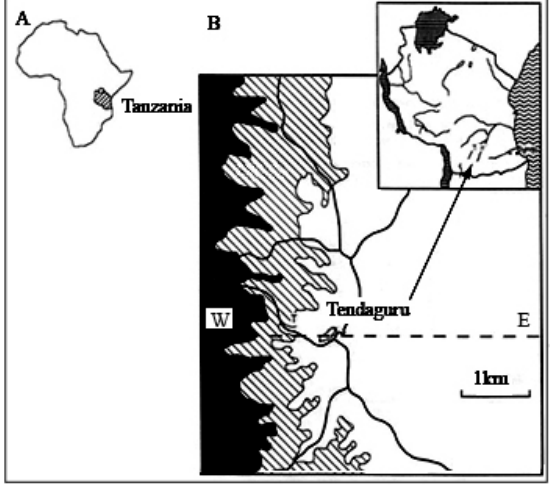
Fig. 1 – Locality map. A. Africa, showing the location of Tanzania. B. Tendaguru site (adapted from Unwin and Heinrich